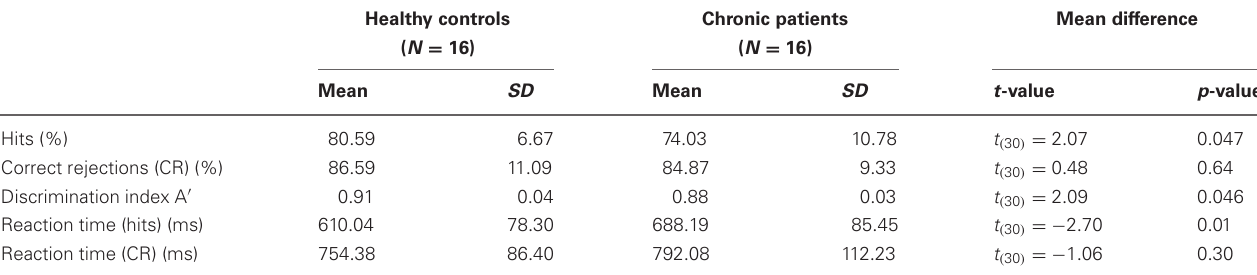
Table 2 | Means, standard deviations and mean differences for behavioral performance in controls and patients. Healthy controls Chronic